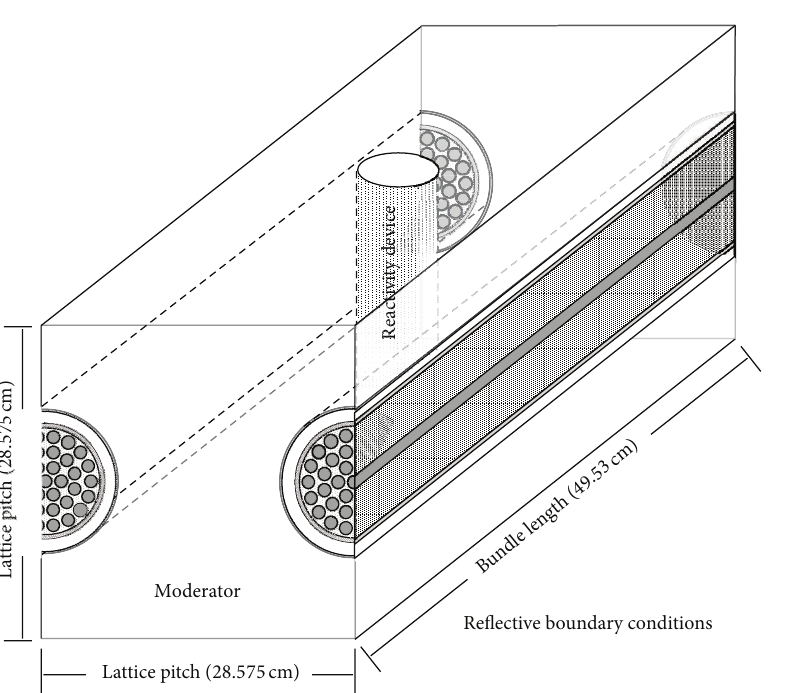
Figure 6: McCARD supercell